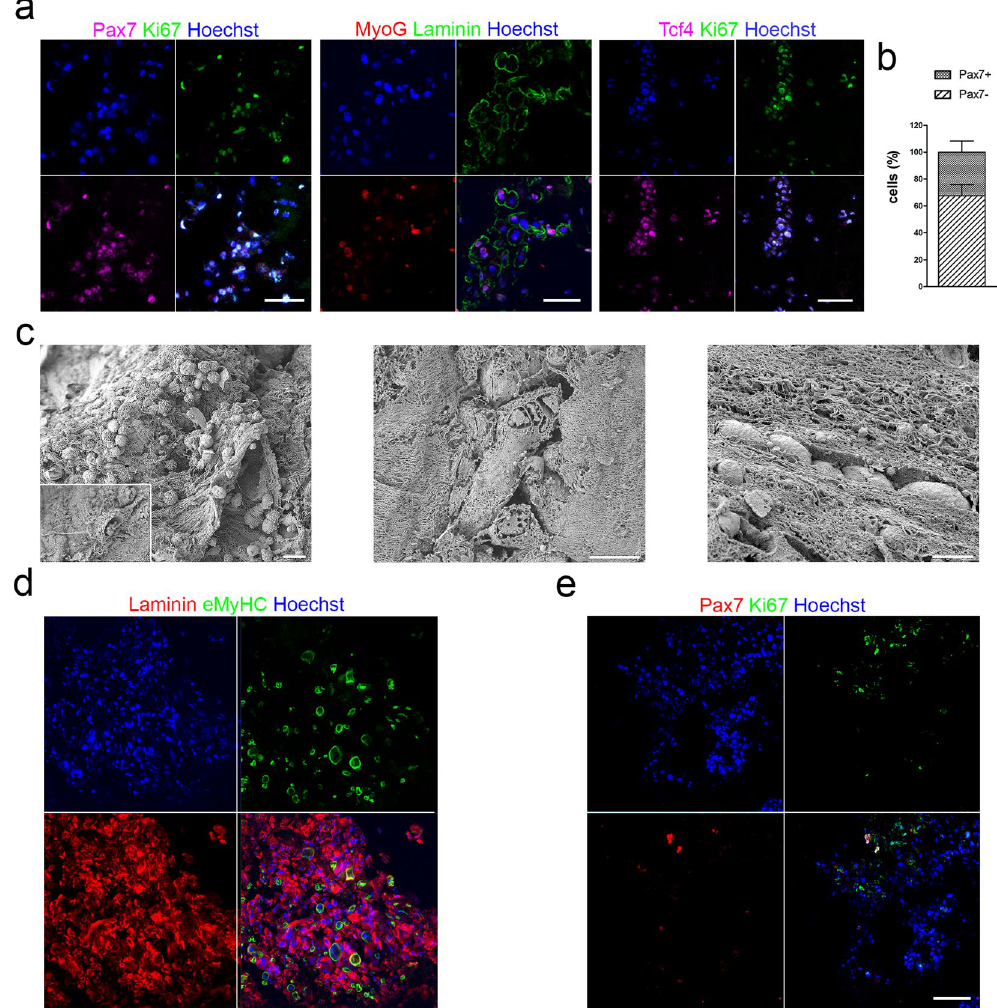
Figure 9. Characterization of SDS scaffolds repopulated with MuSCs and FBs. ( a ) Immunofluorescence analysis of scaffold cross-sections seeded with MuSCs-FBs and cultured for one week by using Pax7 (magenta) and ki67 (green), or MyoG (red) and laminin (green), or Tcf4 (magenta) and ki67 (green). Nuclei were stained with Hoechst (blue). Scale bar: 100 μ m. ( b ) Percentage of Pax7-positive and negative cells in co-cultured scaffolds after one week. ( c ) SEM analysis showing cell-ECM interaction in SDS scaffolds seeded with MuSCs- FBs and cultured for one week. The insert show a single cell spreading its projections to the ECM. Scale bar: 20 μ m left panel; 10 μ m middle and right panel. ( d ) Immunofluorescence analysis of scaffold cross-sections seeded with MuSCs-FBs and cultured for two weeks by laminin (red) and eMyHC (green). Nuclei were stained with Hoechst (blue). Scale bar: 50 μ m. ( e ) Immunofluorescence analysis of scaffold cross-sections seeded with MuSCs-FBs and cultured for two weeks by Pax7 (red) and ki67 (green). Nuclei were stained with Hoechst (blue). Scale bar: 50 μ